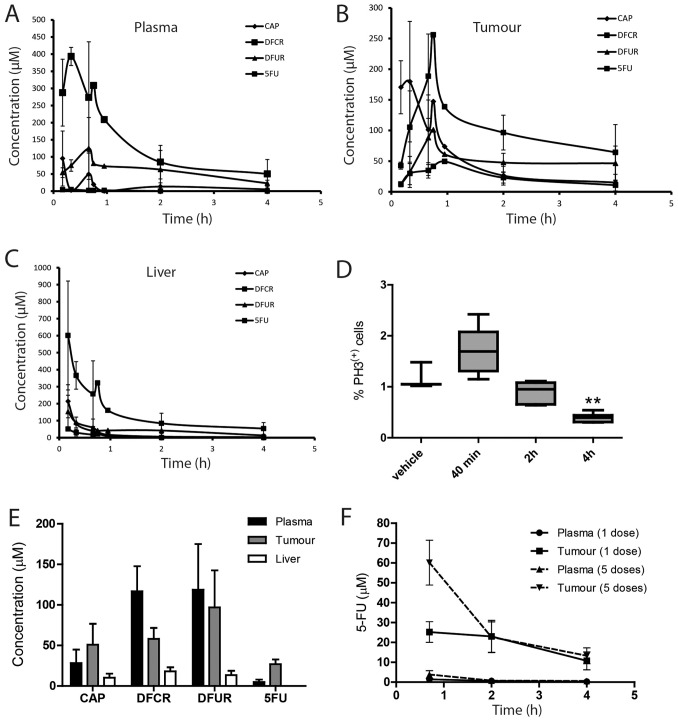
Pharmacokinetic and pharmacodynamics profiles of CAP in mouse tissues.Metabolite concentrations in plasma (A), K8484 allograft tumour homogenates (B) and liver homogenates (C) after a single dose of CAP at 755 mg/kg. Mean ± SD (n = 3 except for 45 min and 1 h where n = 2). (D) Immunohistochemistry for phospho-histone H3 (PH3) quantified in KPC allograft tumours at different time points after a single 755 mg/kg CAP dose. Mean ± SEM of at least three tumours (**p<0.01). (E) Metabolite concentrations in KPC mouse tissues 2 h after the last of 7 consecutive doses of CAP at 755 mg/kg, Mean and SEM of 6 mice. (F) 5-FU concentrations 2 h after a single dose (solid line) or five consecutive doses (dashed line) of CAP (755 mg/kg) given to mice bearing K8484 allograft tumours.